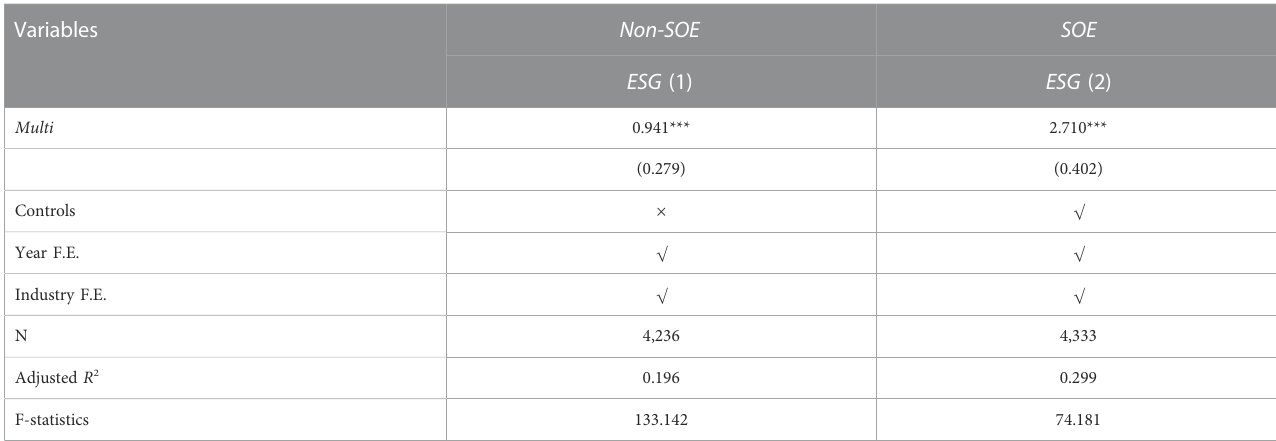
TABLE 7 The role of